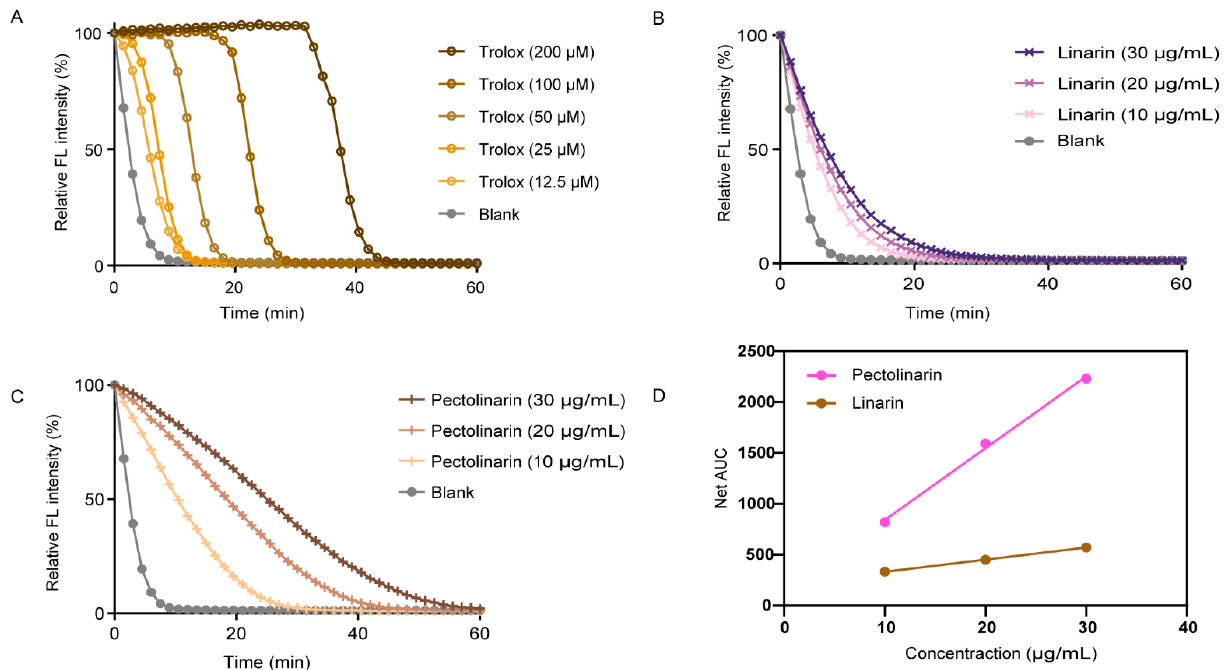
Figure 4. Antioxidant activity of pectolinarin and linarin illustrated by ORAC assay. ( A ) Repre- sentative kinetic curves from ORAC assay of varying concentrations of Trolox ranging from 12.5 µm to 200 µm. ( B ) Representative kinetic curves from ORAC assay of varying concentrations of pectolinarin ranging from 10 to 30 µg/mL. ( C ) Representative kinetic curves from ORAC assay of varying concentrations of linarin ranging from 10 to 30 µg/mL. ( D ) Linear relationship between Net AUC and concentration of pectolinarin and linarin.